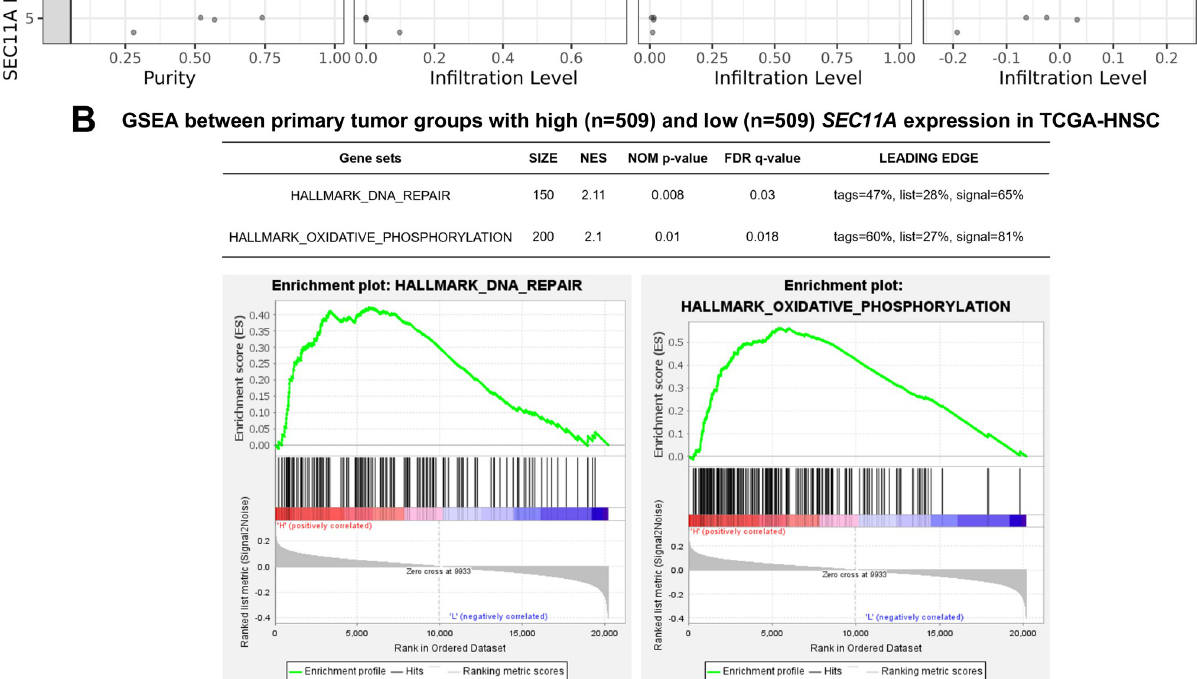
PLOS ONE | https://doi.org/10.1371/journal.pone.0269166 June 2,